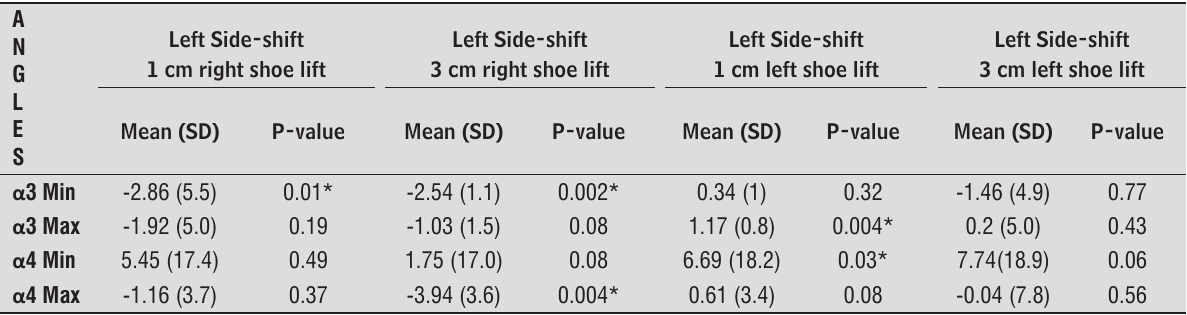
Table 3 - Difference between means (maximum and minimum) of α 1, α 2, α 3 and α 4 in side-shift movements to the left with shoe lifts of 1 cm and 3 cm in relation to the static position and p value